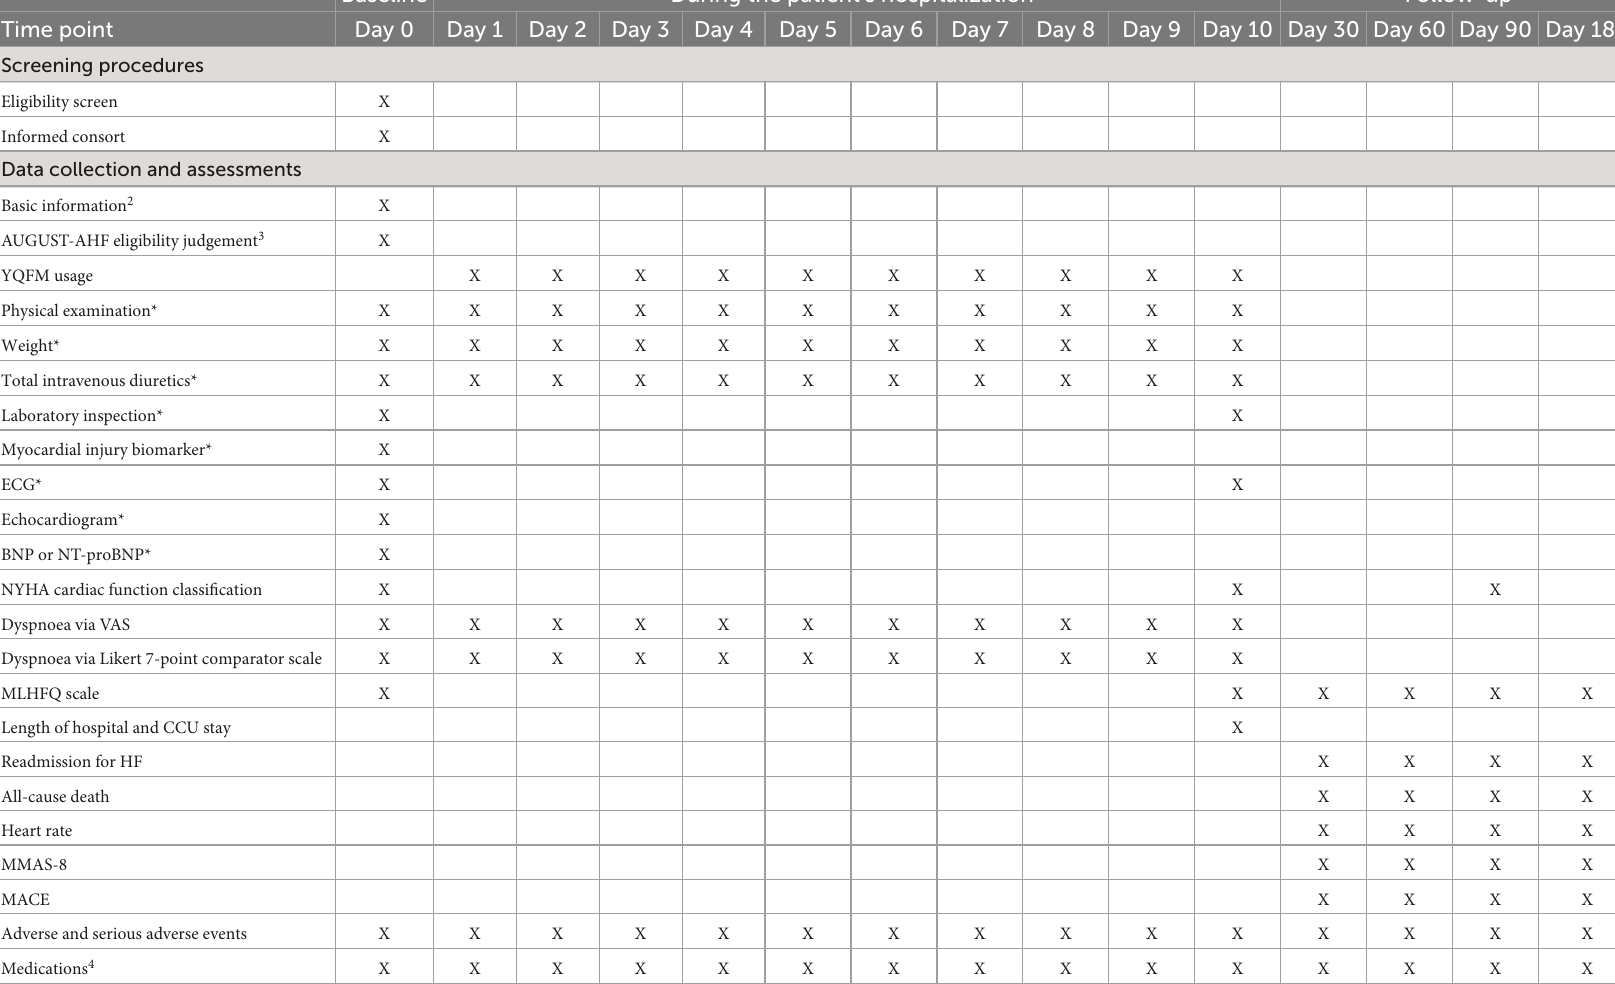
TABLE 2 The schedule of assessment and data collection. Baseline During the patient’s hospitalization 1